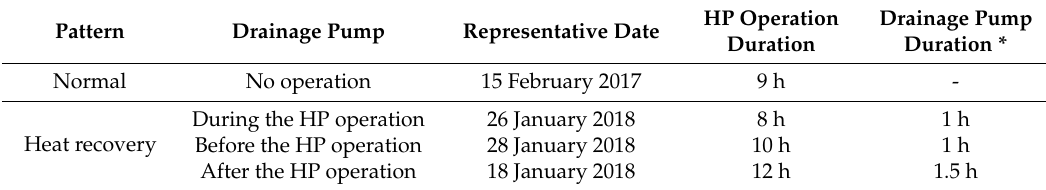
Table 4. Operation